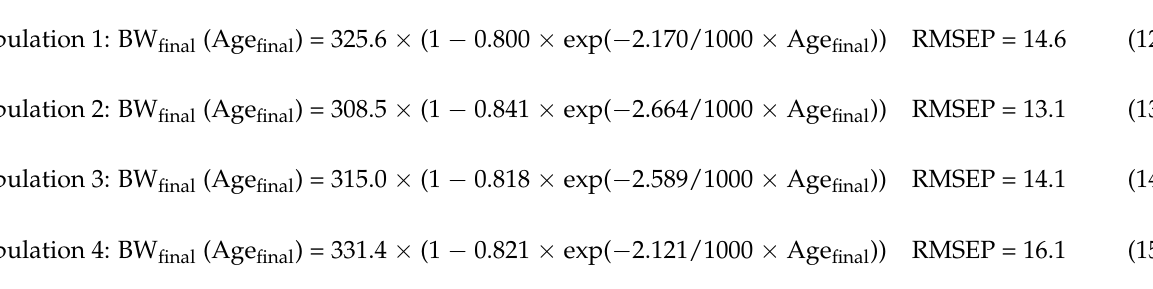
Figure 2. Individual ages and body weights at farrowing of sows in population 4 (born from 2012–2015), along with body weight predicted using the Weibull model (Equation (19)). Modelling BW final as a function of Age final using the monomolecular Brody